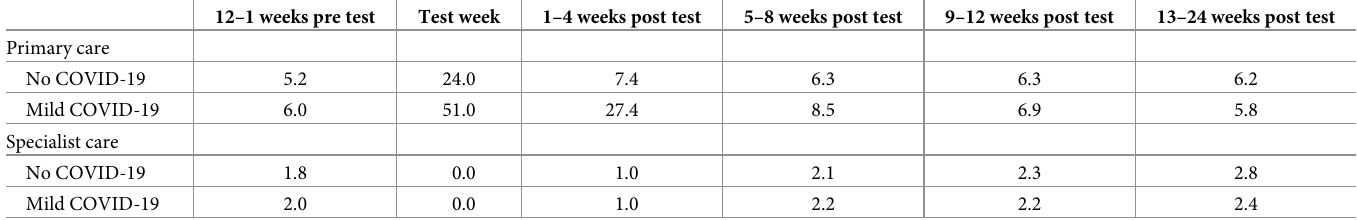
Table 2. Percent of tested persons who used health care services per week in given time periods before and after PCR test for SARS-CoV-2, by use of primary and specialist (outpatient or inpatient) care during, separately for those with no or mild